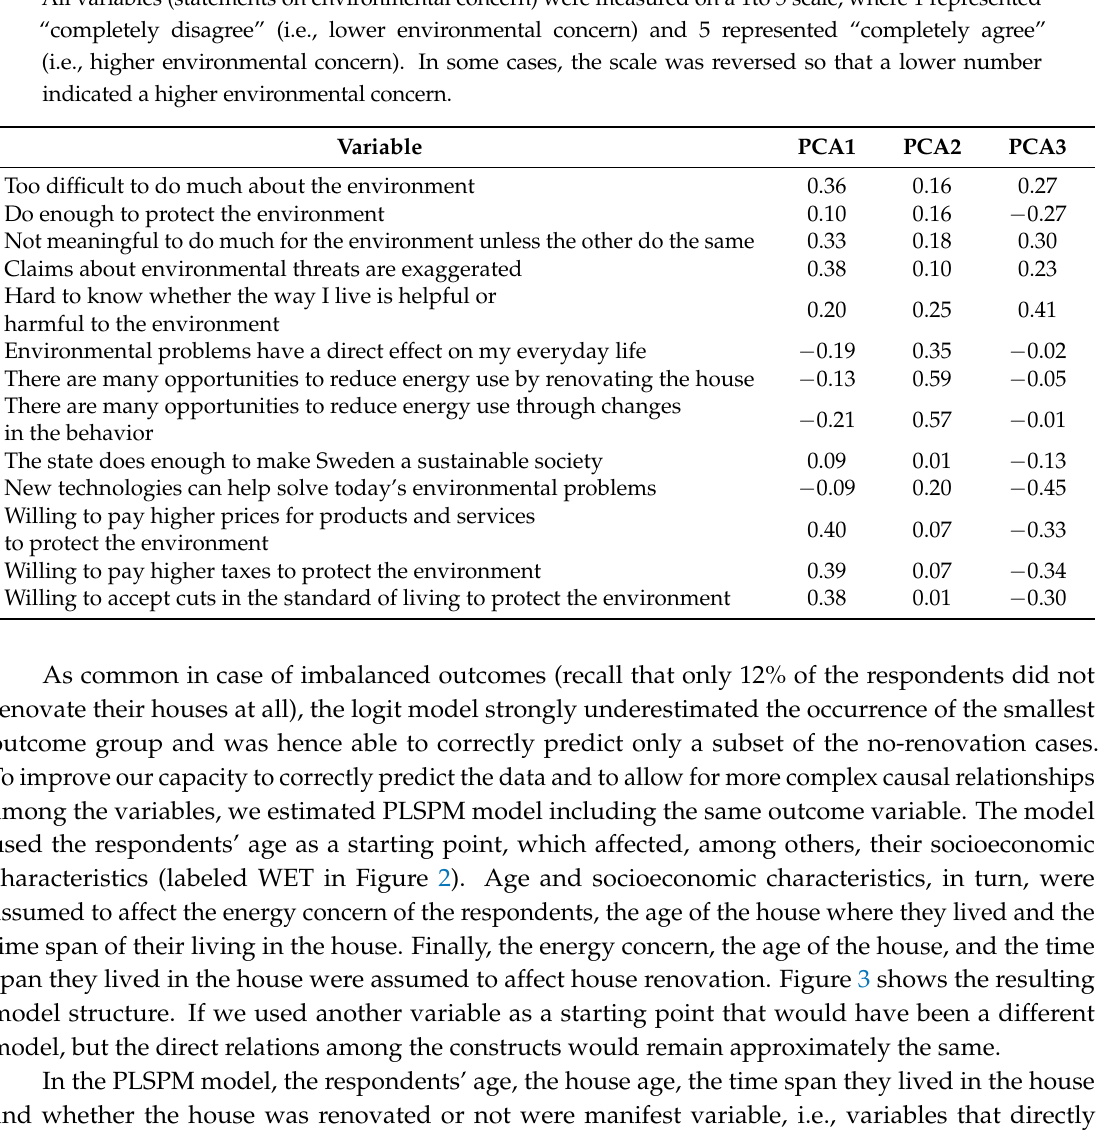
Table 1. Variables included in the PLS principal component analysis and corresponding